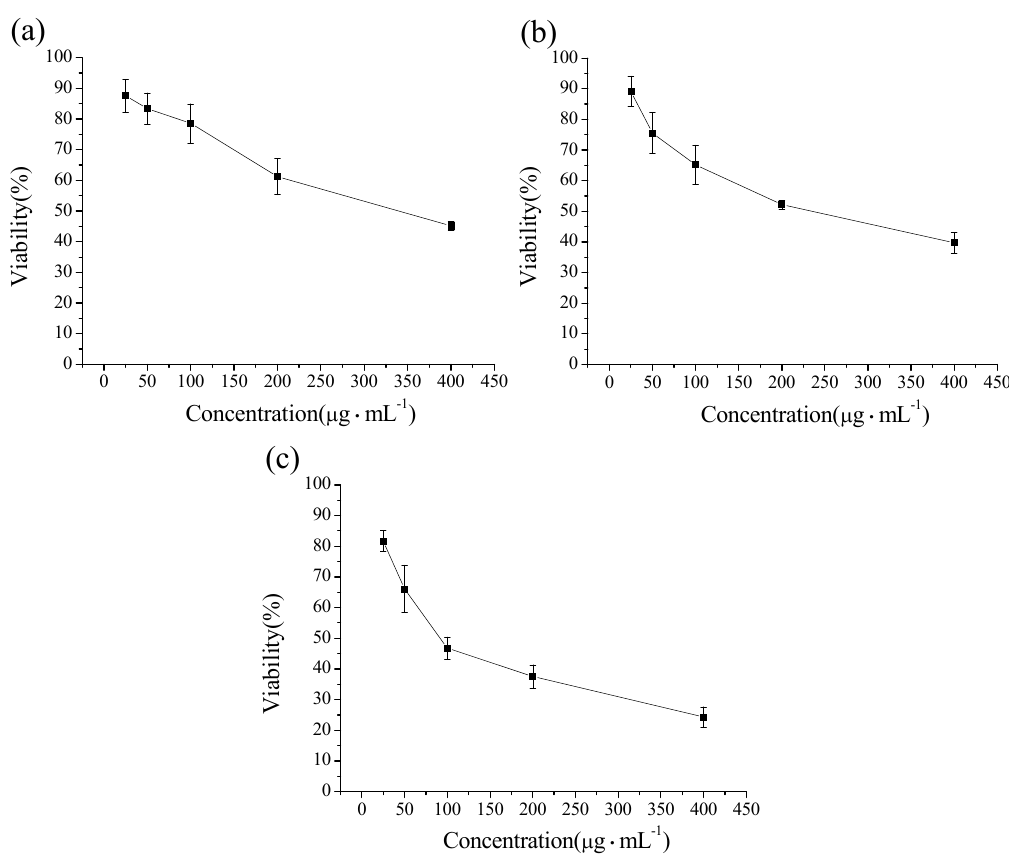
Figure 2. Viability determination of RAW264.7 cells exposed to different sized NCBs for 24 h. ( a ) Printex 90; ( b ) Printex G; and ( c ) Flammruss 101.